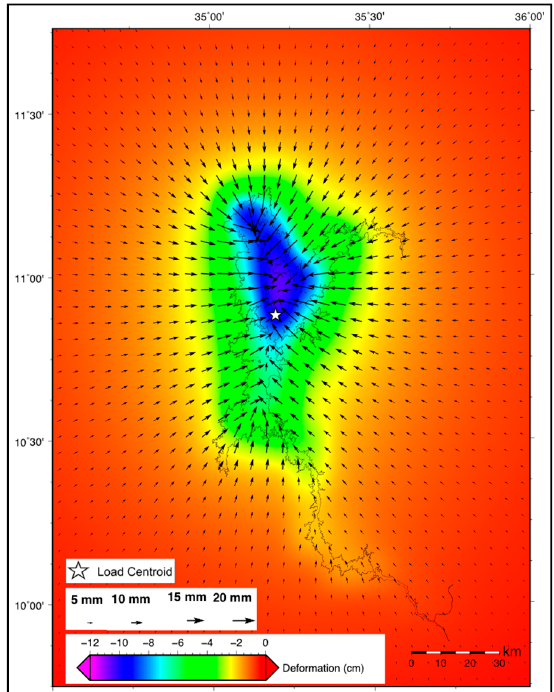
Figure 2. Vertical and horizontal displacements from the full GERD impoundment. The modeled vertical displacement is plotted on the colored grid while the horizontal displacement motion vectors are plotted on top. The weighted hydrologic load centroid from the full reservoir volume is plotted as a star. The total areal extent of the full impoundment (640 m reservoir level) is drawn as a black polygon. These are the modeled elastic displacements from the full hydrologic loading for the entire GERD impoundment.